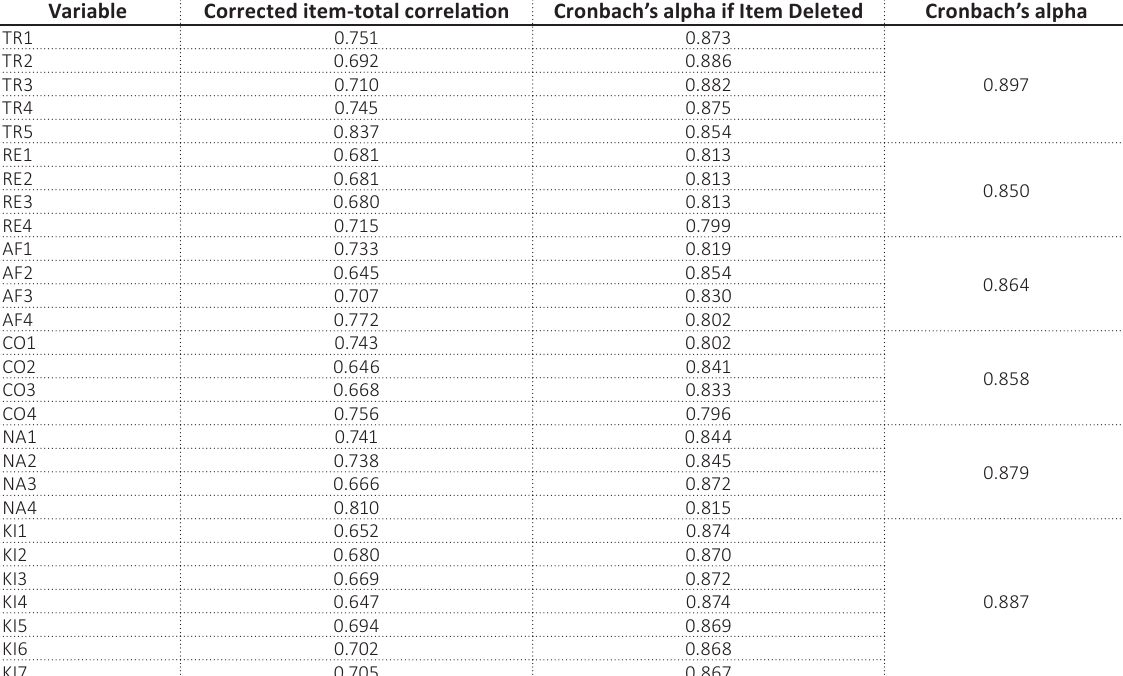
Table 3. Reliability analysis